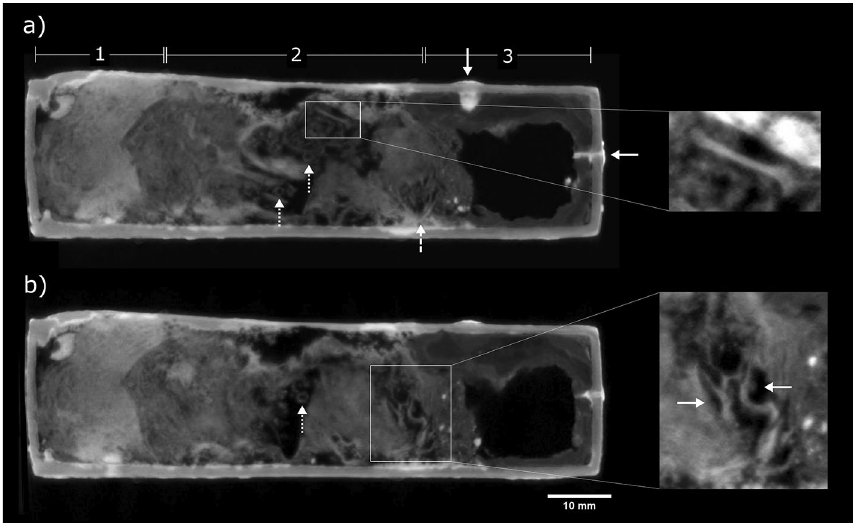
Figure 4. EA36167 multiplanar neutron CT slices, averaged over 0.55 mm slice thickness: ( a ) top-view slice centred 6.9 mm from base of box showing three internal regions, ( 1 ) plaster plug sealing the box, ( 2 ) textile and animal remains, ( 3 ) lead with void in centre (solid arrows: corroded chaplets; dotted arrows: vertebrae, transverse cross-sections; dashed arrow: lizard skull; inset: contrast-enhanced view of a long bone measuring 6.2 mm in length); ( b ) top-view slice centred 8.9 mm from base of box (dashed arrow: vertebra; inset: contrast- enhanced view of upper part of lizard skull in top-view, with orbits indicated by solid